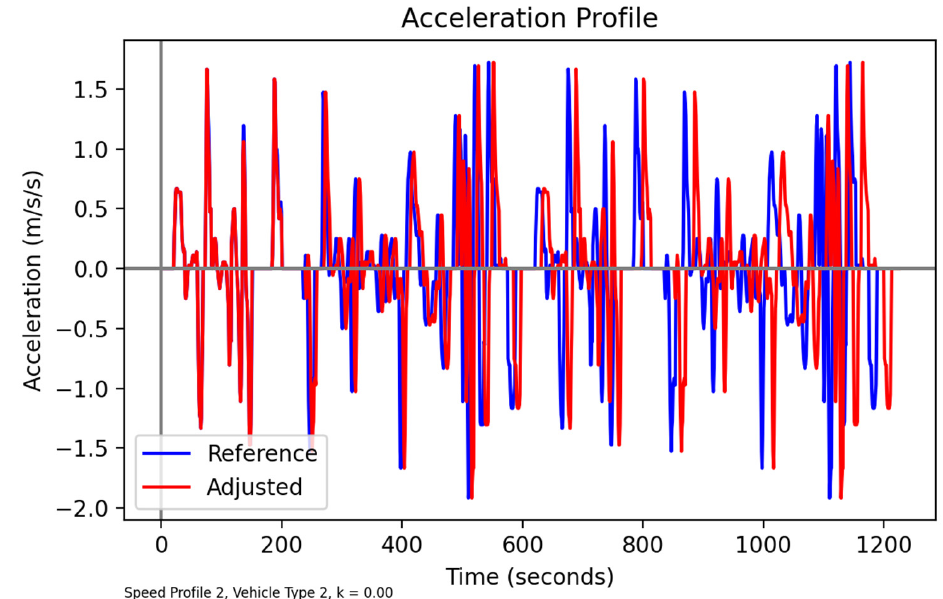
Figure 9. Acceleration profile for adjusted and reference speed profiles (WMTC Reference Cycle 2, Vehicle Type 2, Flat terrain assumed in adjustment).